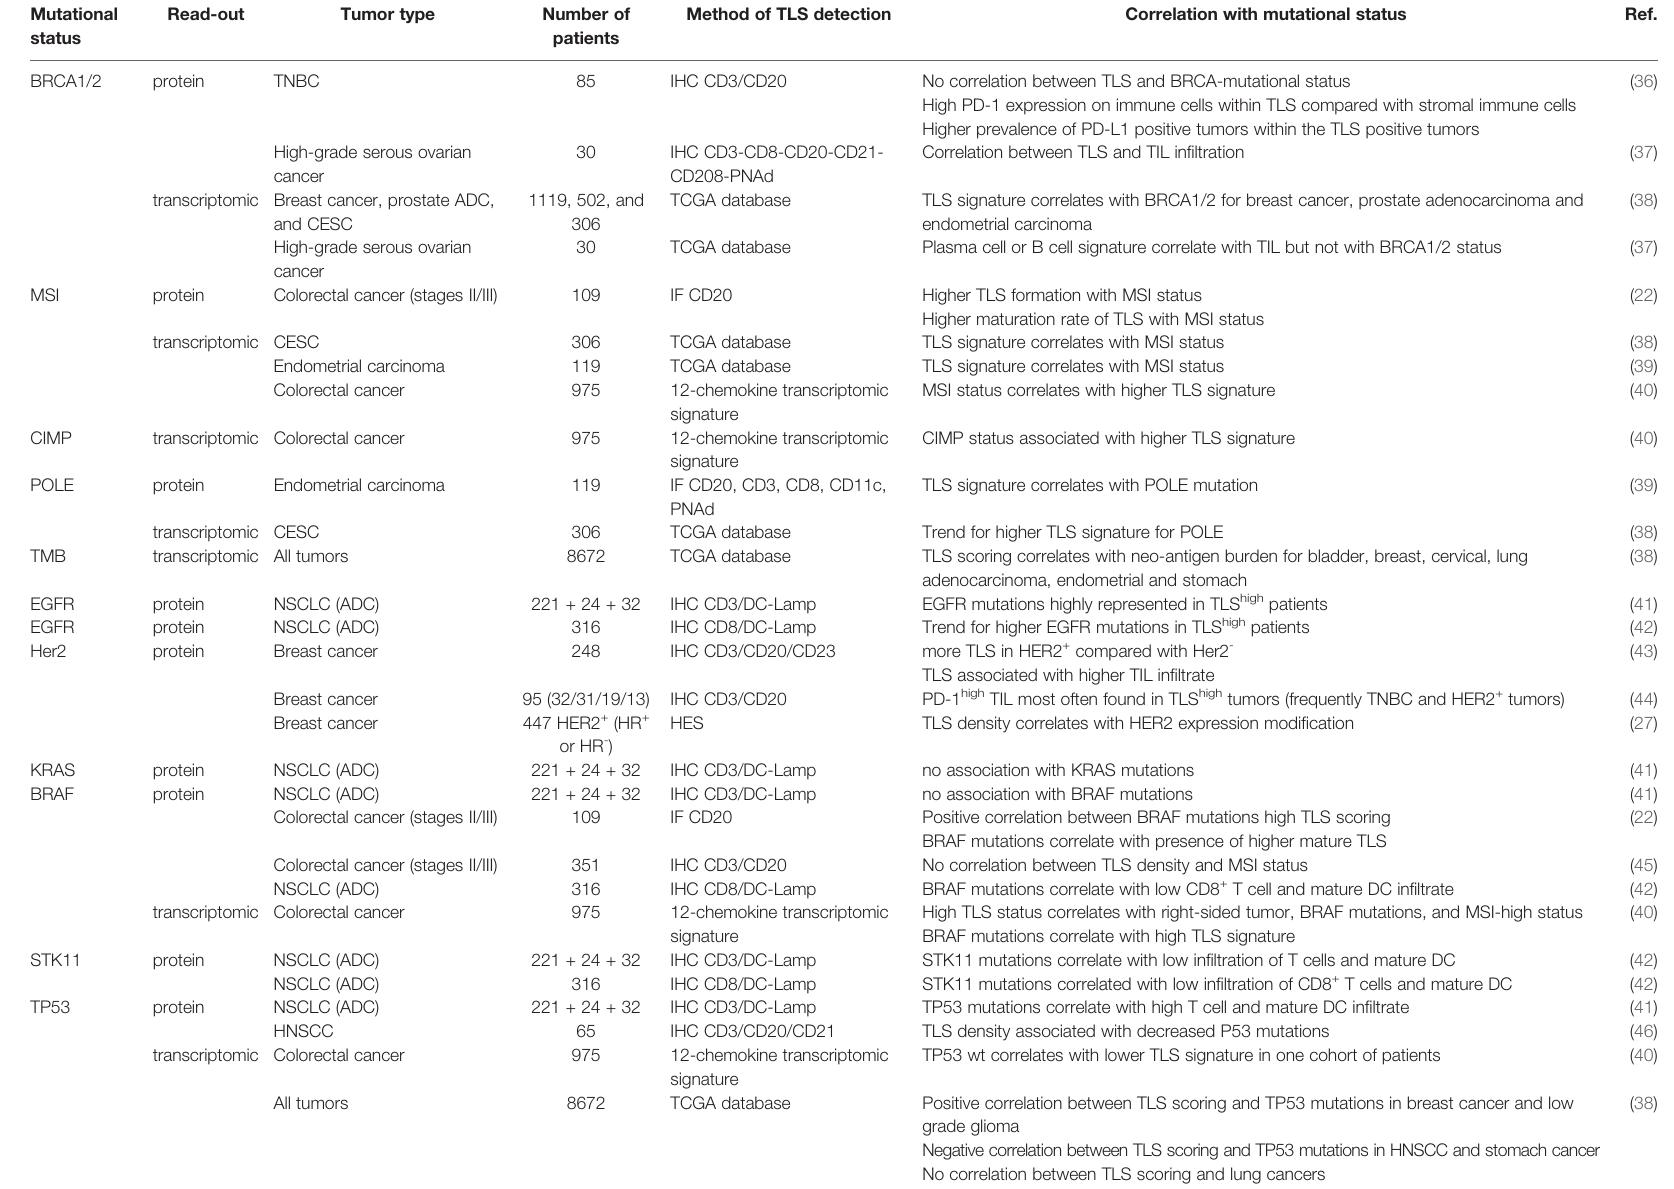
TABLE 1 | Correlation of TLS signature with driver gene mutations in human